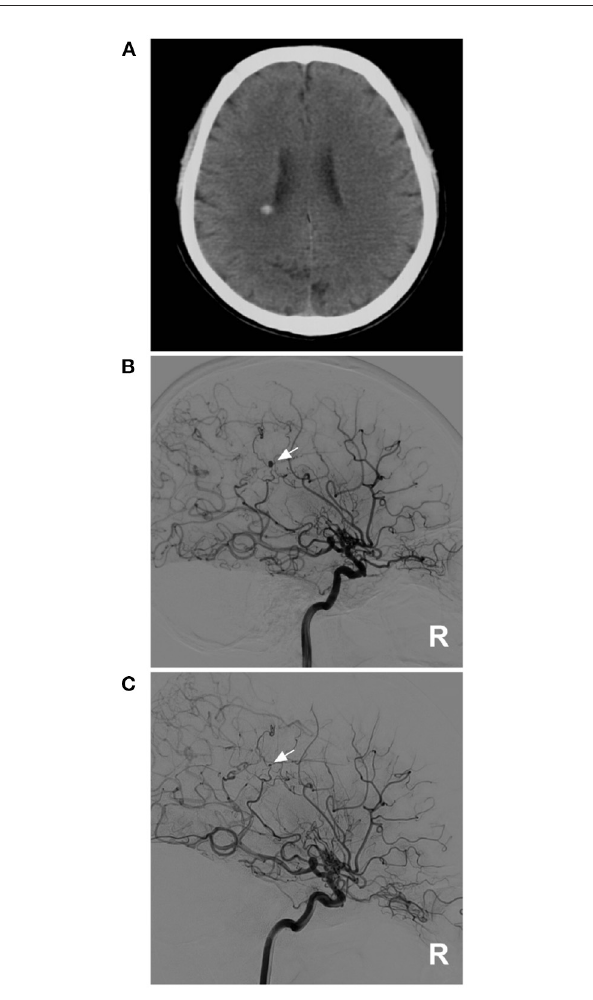
FIGURE5 A diminishing aneurysm in case 1 in Table 2. (A) CT showed hemorrhage on the lateral ventricle wall. (B) DSA of the right ICA showed an aneurysm on the distal AchA (arrow), and MMD can be seen on this side. (C) One month later, repeat DSA of the right ICA showed that the aneurysm was diminishing, and only a remnant could be seen (arrow). AchA, anterior choroidal artery; CT,